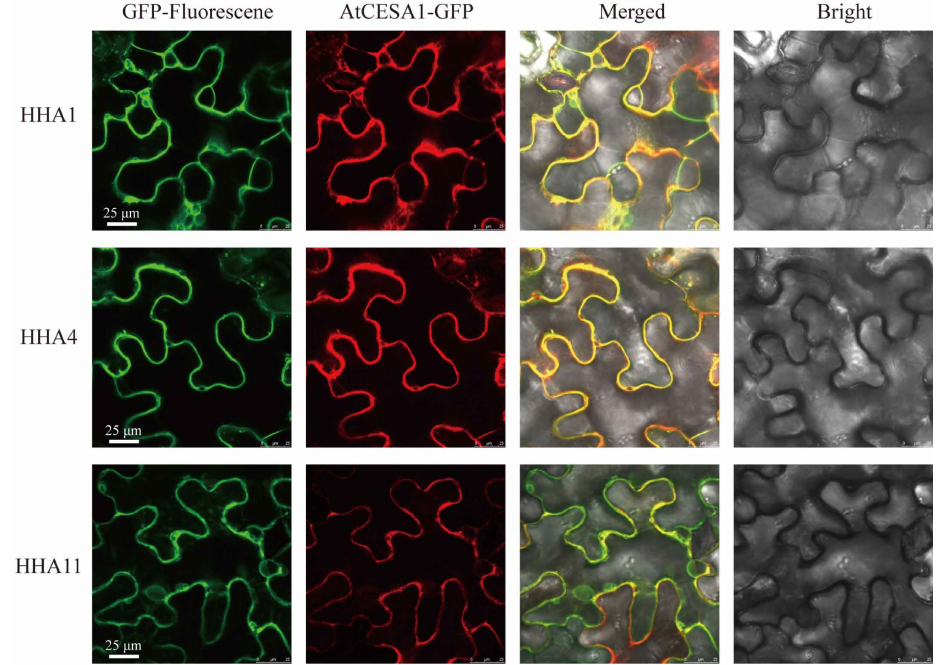
Figure 7. Sunflower HHA1, HHA4, and HHA11 fusion protein subcellular localization. AtCESA1-RFP is a plasma membrane-anchored marker